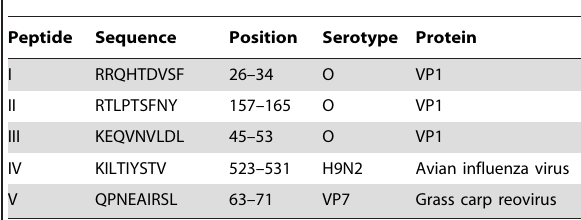
Table 1. Three synthetic peptides from the VP1 capsid protein of FMDV and two unrelated peptides from AIV H9N2 and Grass carp reovirus,